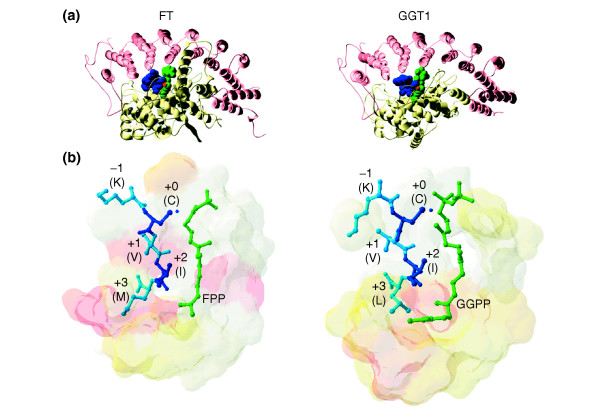
The two CaaX prenyltransferases. (a) Ribbon representations of FT (PDB 1D8D [75]) and GGT1 (PDB 1N4Q [76]); pink, alpha subunit; yellow, beta subunit. (b) The prenylpyrophosphates (green) and CaaX tetrapeptides (blue) inside the binding pockets with enzyme-specific conservation (conservation in FT or GGT1 minus conservation in joined FT+GGT1 alignment) mapped to binding-pocket surface. Increasing conservation difference is shaded from white to yellow to red. FPP, farnesyl-, GGPP, geranylgeranylpyrophosphate. The alignment of the sequences of these proteins is shown in Figure 6. Visualized with Swiss-Pdb Viewer [59].